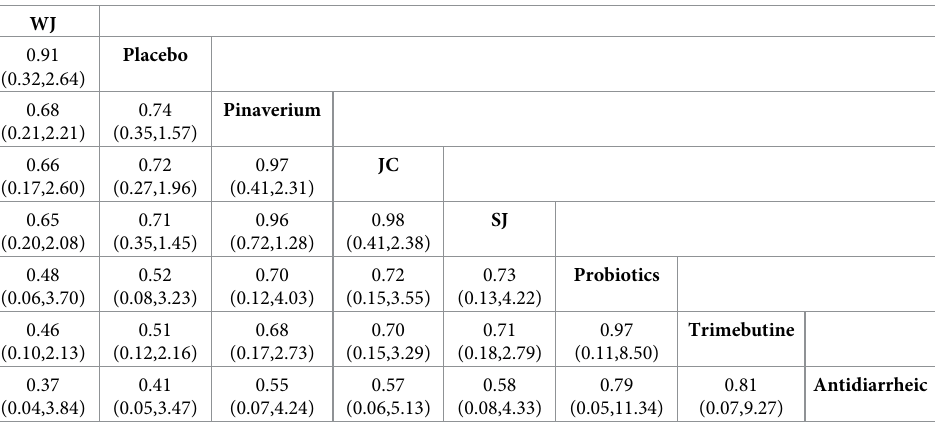
Table 7. Risk ratio with 95% confidence interval of adverse effects.